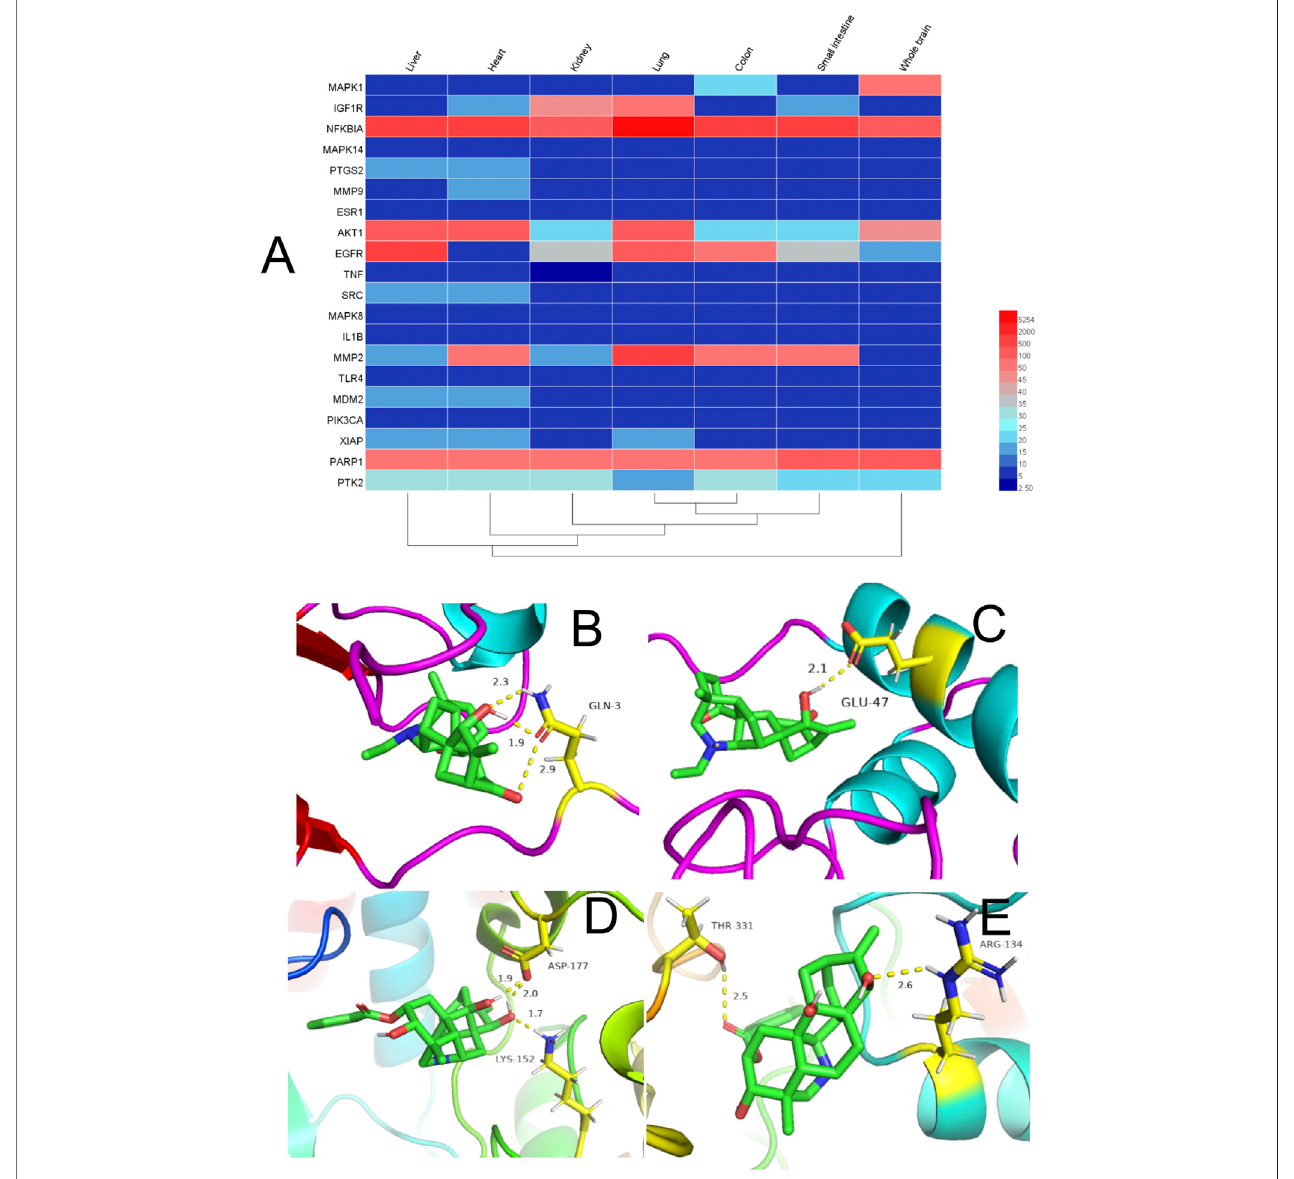
FIGURE5|(A) Heatmap oforganexpressionof20targets. Thex-axisindicatestheorganname.They-axisindicatesthetargetname;fromlefttoright,liver,heart, kidney, lung, small intestine, and whole brain. (B-E) Binding studies of selected compound – target interactions. (B) Songoramine with MAPK14. (C) Songoramine with MMP9. (D) IgnavinewithMAPK14. (E) IgnavinewithMMP9.Moleculesarerepresentedbyaball-and-stickmodel.Hydrogenbondsarerepresentedbyadottedline,and numbers indicate hydrogen-bond distances in angstroms. Atoms C, O and N are green, red and blue,